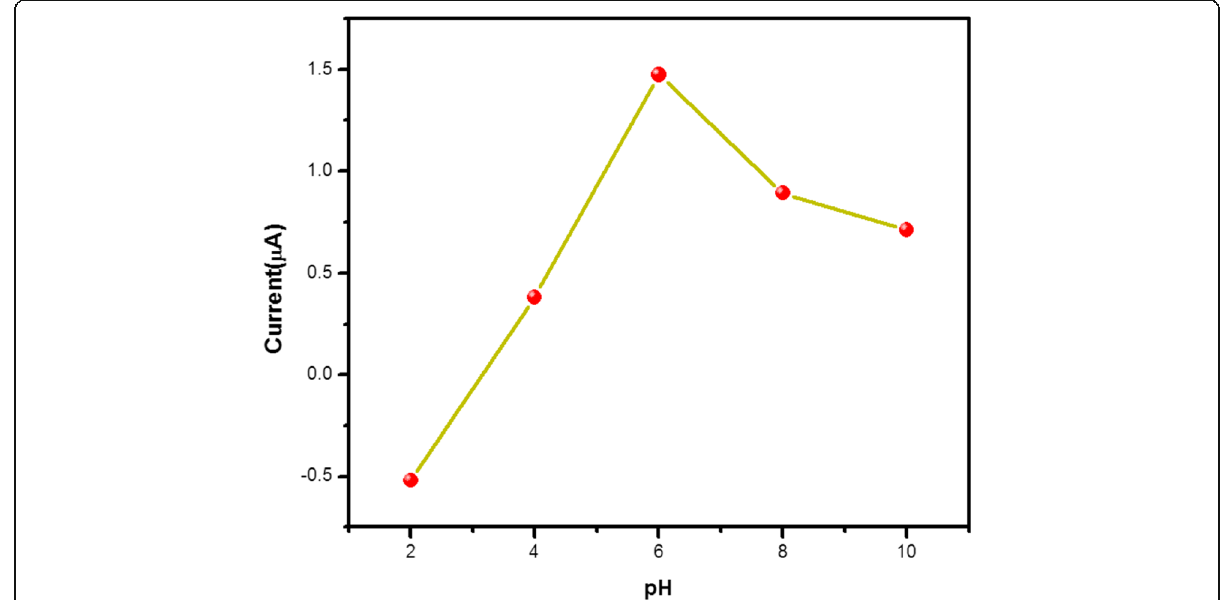
Fig. 9 Effect of pH on the peak current of Cd(II)